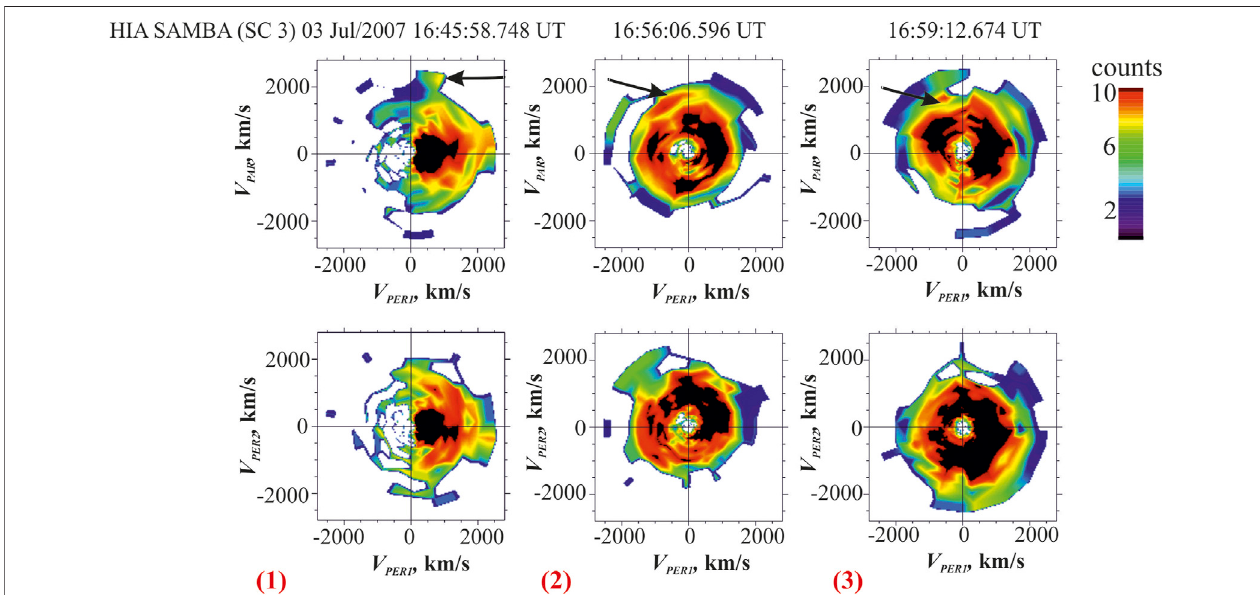
FIGURE 8 | Ion velocity distribution functions as measured by the HIA instrument onboard SC 3 at 16:45:58.748 UT (left) , 16:56:06.596 UT (middle) and 16:59: 12.674 UT (right) during 12 s time-averaged ion velocity distribution functions. V PAR is directed along B , V PER 1 is directed along − V × B and V PER 2 direction completes the orthogonal system. The black arrows indicate the fi eld-aligned beams. The time of observation for distributions (1), (2), and (3) correspond to that similarly noted in Figure 3 .